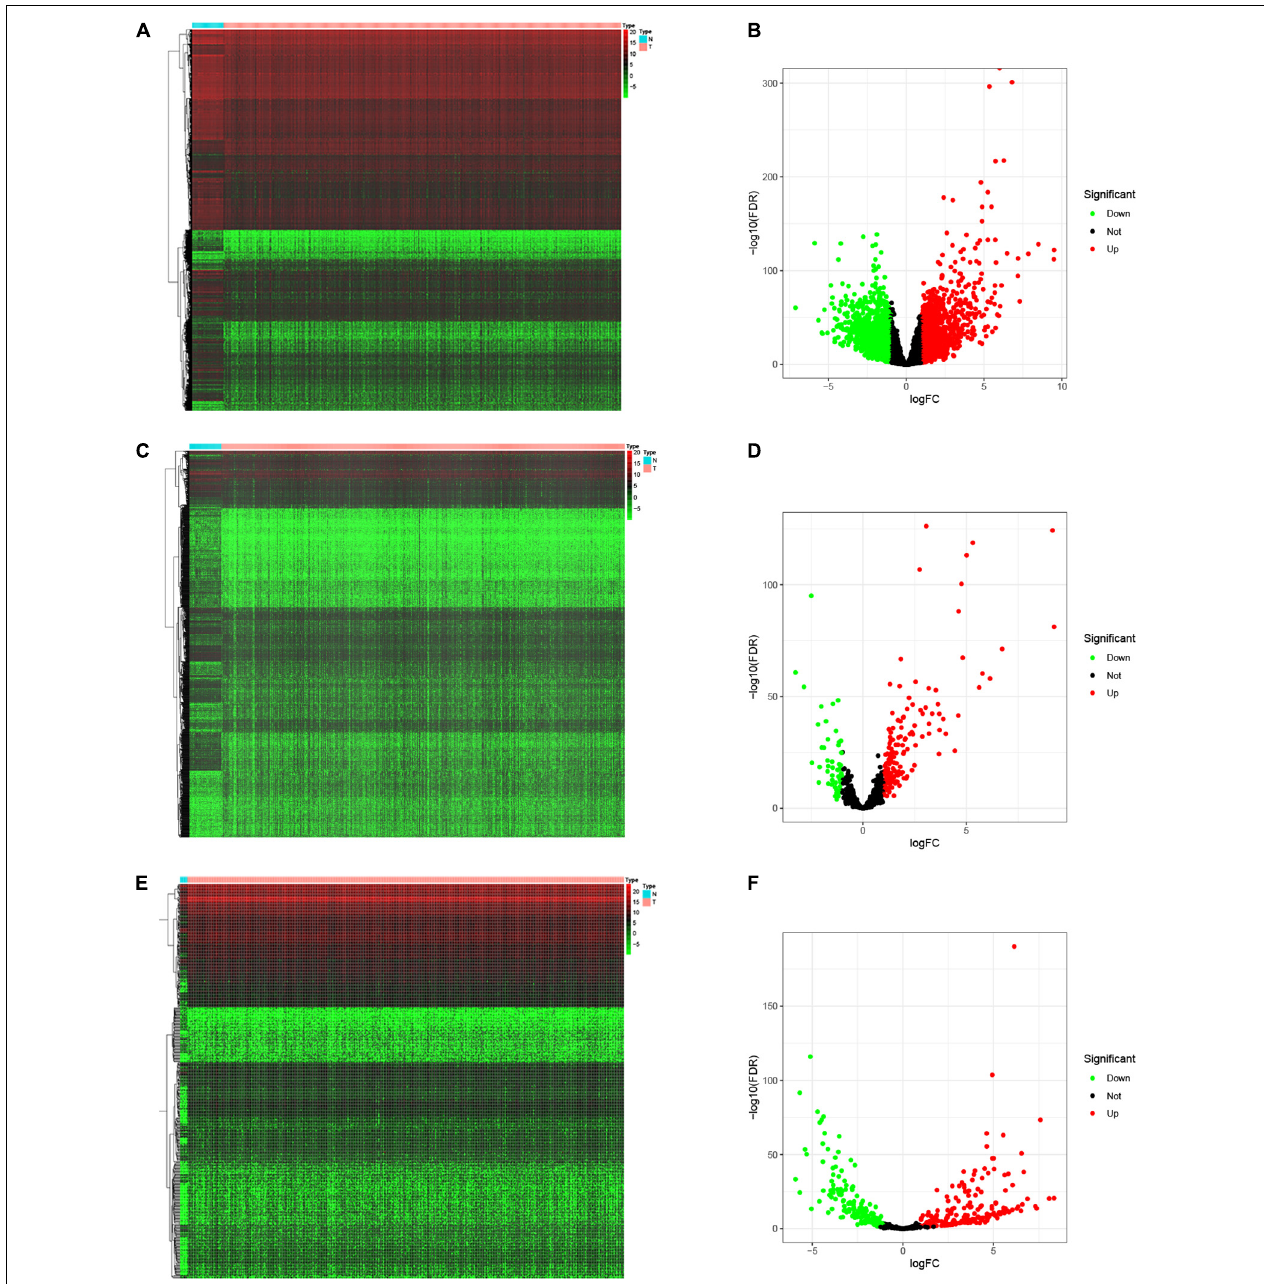
FIGURE 1 | Differential expressed genes. The “limma” package of R was utilized to identify the differentially expressed genes. Heat map and Volcano map was plotted to visualize the differentially expressed mRNAs (A,B) , lncRNAs (C,D) , and miRNAs (E,F) . Red dots represent up-regulation and green dots represent down-regulation of differential expressed